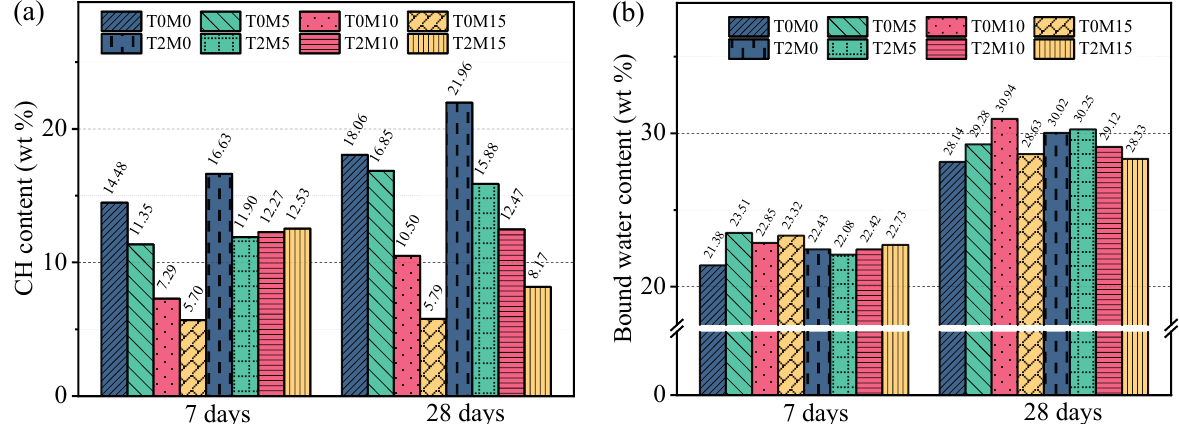
Figure 8. Mass loss of different hydration products and total bound water of MK blended pastes with BTE obtained from the TGA results: ( a ) CH; ( b ) bound water.